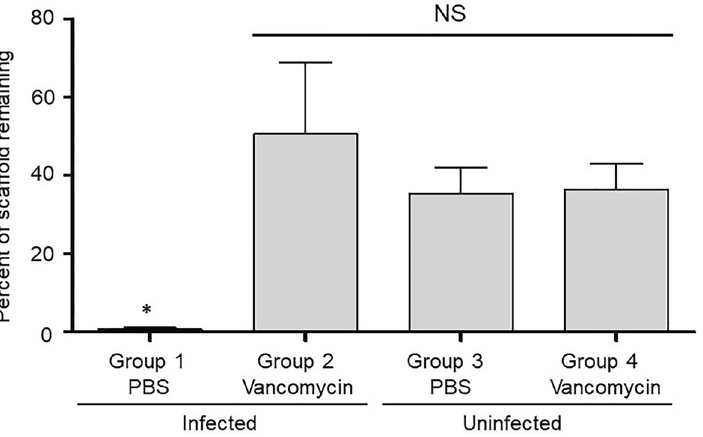
Figure 5. Percentage of K20/100 scaffold formulation remaining as a function of infection status and antibiotic loading. Bone surrounding the surgical site was harvested after 84 days and subjected to µCT analysis. The volume of scaffold remaining in the surgical site was calculated and compared to the volume of control scaffolds prior to implantation (Fig. 1). Results shown are the average ± the standard error of the mean for each experimental group. Asterisk indicates a statistically significant difference by comparison to the uninfected control group in which the surgically-created bone defect was not contaminated and filled with PBS-saturated scaffold (Group